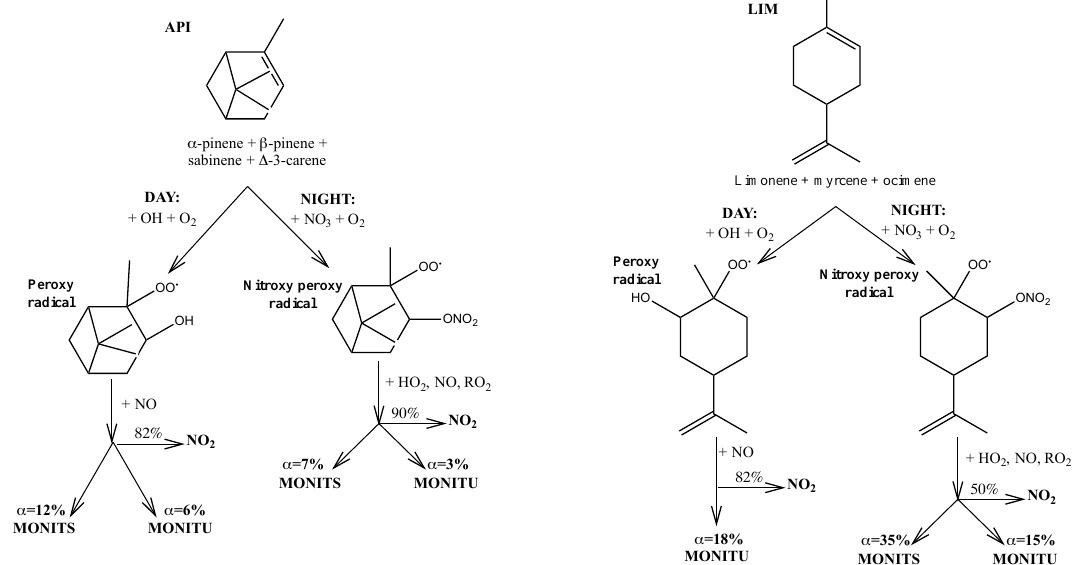
Figure 3. Simplified representation of the formation of monoterpene nitrates (MTN) from monoterpene oxidation as implemented in GEOS- Chem. For each lumped species, only one indicative form is